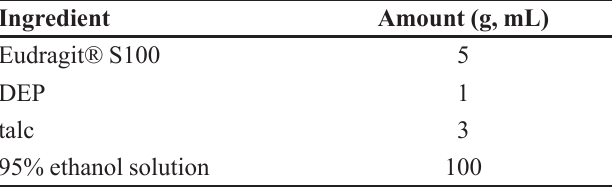
TABLE III - Enteric coating formulation